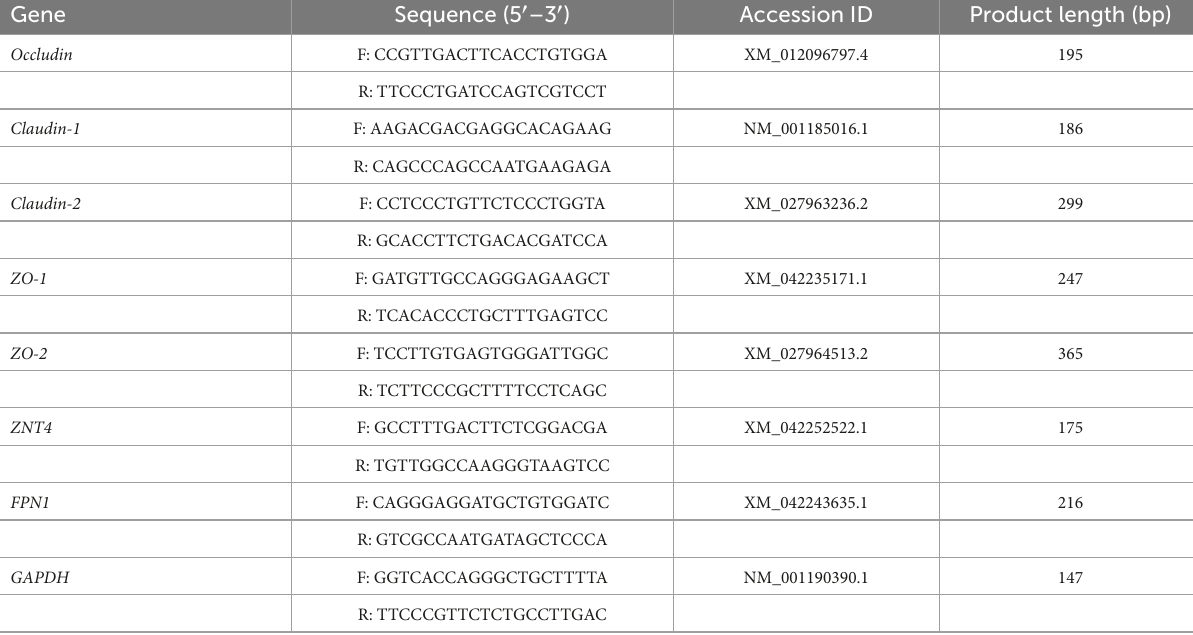
TABLE 2 The sequence and product size of genes.